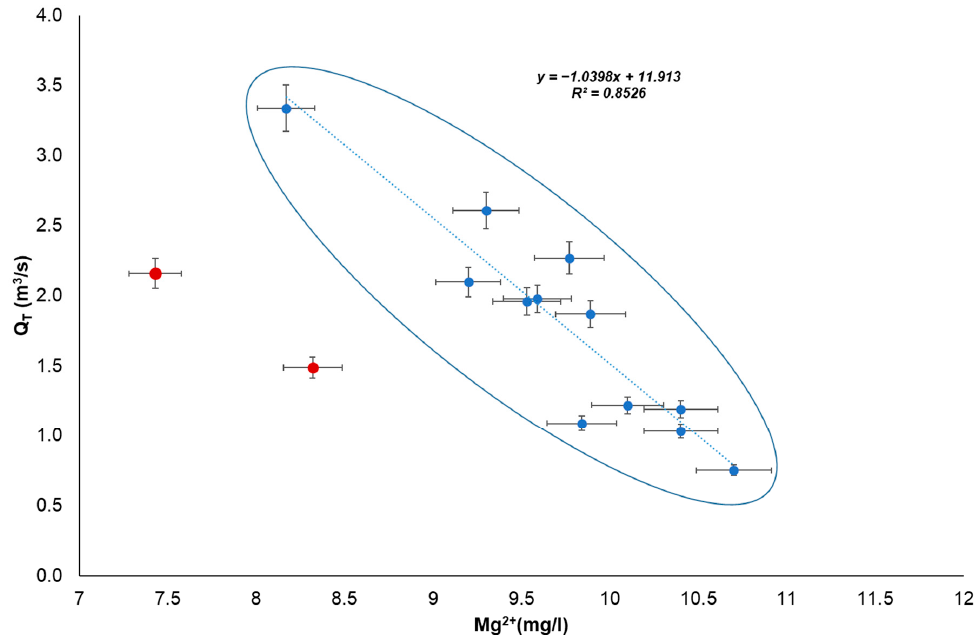
Figure 5. Mg 2+ vs. Pertuso Spring total monthly discharges scatter plot with errors related to chemical analyses ( ± 2%) and discharge measurements ( ±